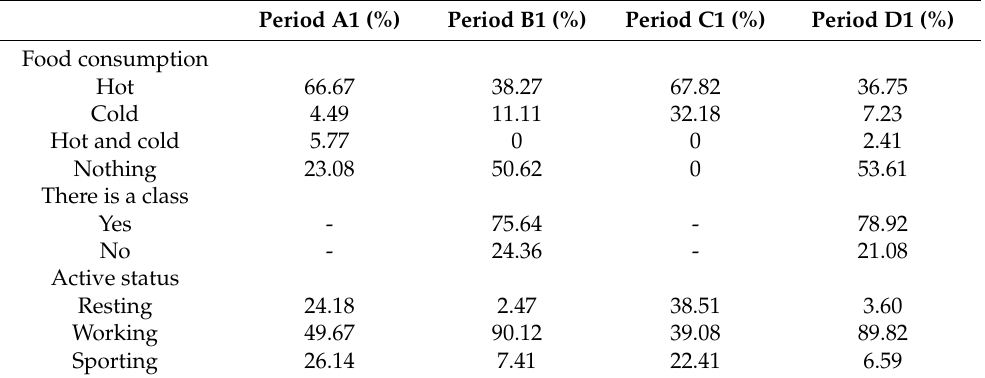
Table 10. Student information before class.